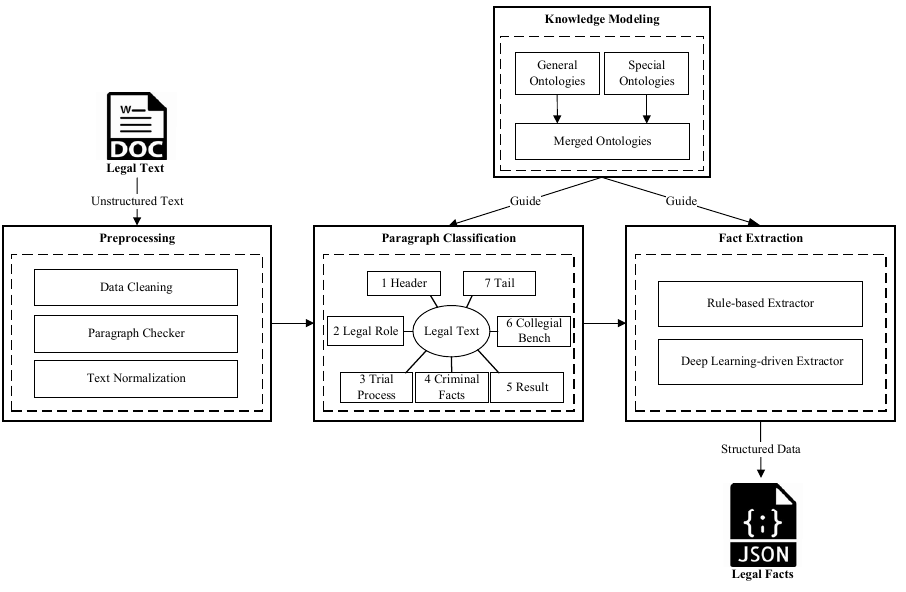
Figure 1. Overall architecture of the proposed